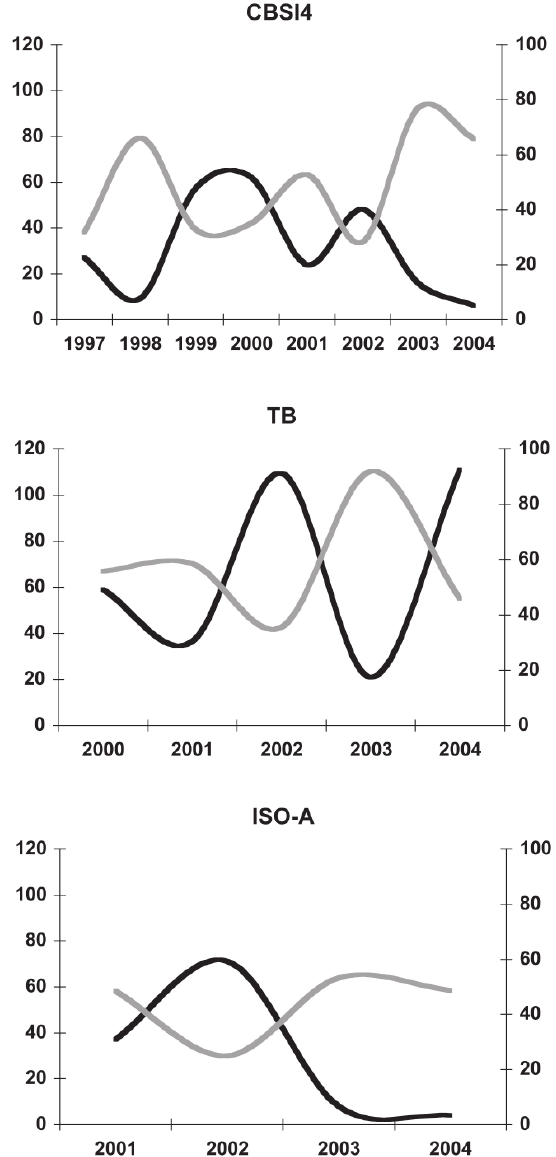
Fig. 3. Relation between rainfall in July and the per- centage of standing vines with hidden (i.e. asymptomat- ic) esca in three vineyards at Siena (CBSI4), Ravenna (TB) and Florence